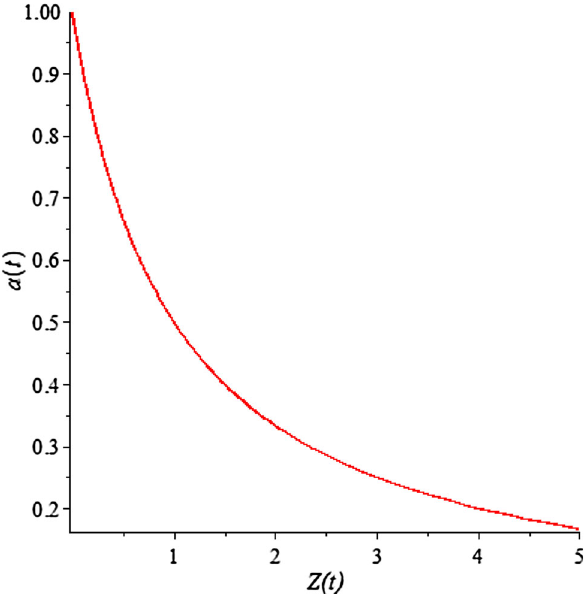
Fig. 2 Scale factor a versus redshift z plot confirms that the present value of the scale factor a 0 = 1